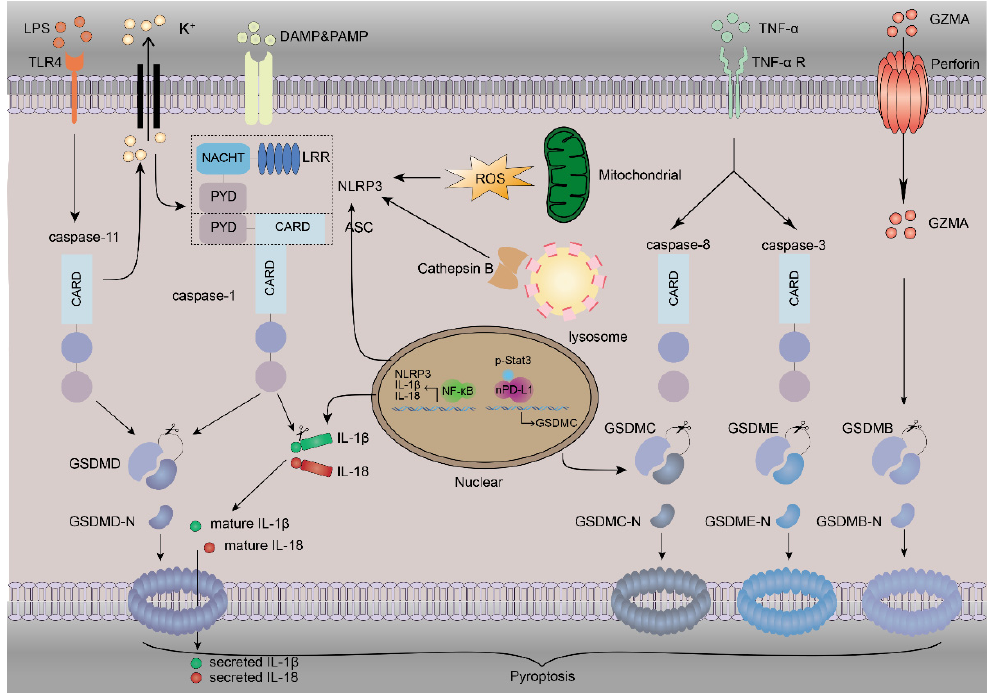
Figure 1. The mechanism of pyroptosis. Pyroptosis involves many proteins. NLRP3 inflammasome activation requires DAMPs or PAMPs to trigger the NF- κ B-mediated upregulation of NLRP3, IL-1 β and IL-18. The instigation of NLRP3 inflammasomes by K + efflux increases the amount of ROS and the release of lysosomal cathepsin B, and subsequent caspase-1 activation leads to the direct cleavage of GSDMD, IL-1 β and IL-18, inducing pyroptosis and inflammation. The binding of LPS to TLR4 stimulates the activation of caspase-11. Caspase-11 can also directly cleave GSDMD to release the N-terminal fragment of GSDMD (GSDMD-N), which can oligomerize to form pores and cause pyroptosis. This process can also cause NLRP3 activation by K + efflux via nonselective pores. TNF- α binds with its receptor to activate caspase-3 and caspase-8. GSDME is cleaved by caspase-3, and GSDMC is transcriptionally upregulated by nPD-L1, which interacts with p-Stat3 in hypoxia and is cleaved by caspase-8 to induce pyroptosis. The GZMA released from cytotoxic lymphocytes and NK cells can enter the cytoplasm through perforin to cleave GSDMB, leading to